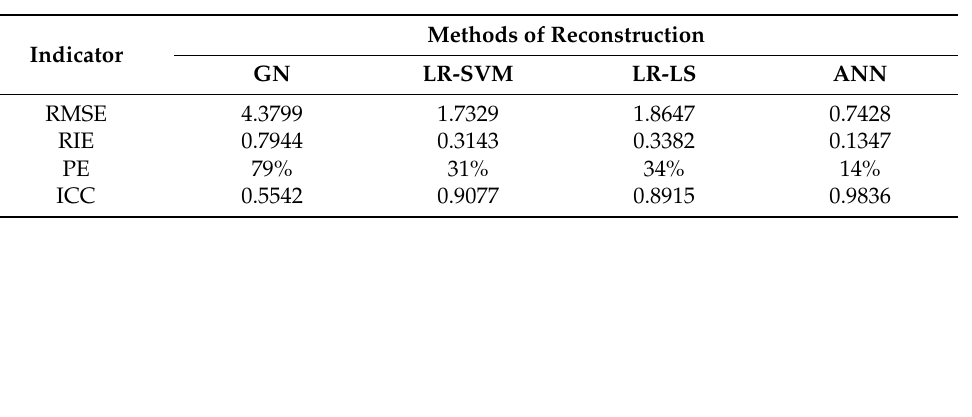
Figure 13. Generating simulation data on finite element meshes: ( a ) dense mesh, ( b ) sparse mesh, ( c ) voltage distribution for individual measurements. Table 4. Indicators characterizing the quality of reconstruction for individual methods and